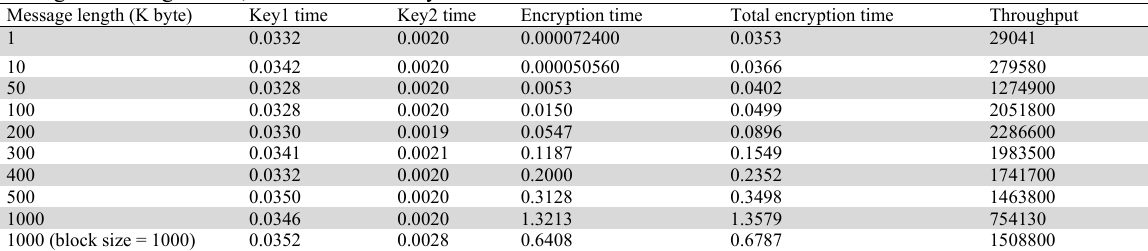
Messages blocking results, block size = 400 byte Message length (K byte)